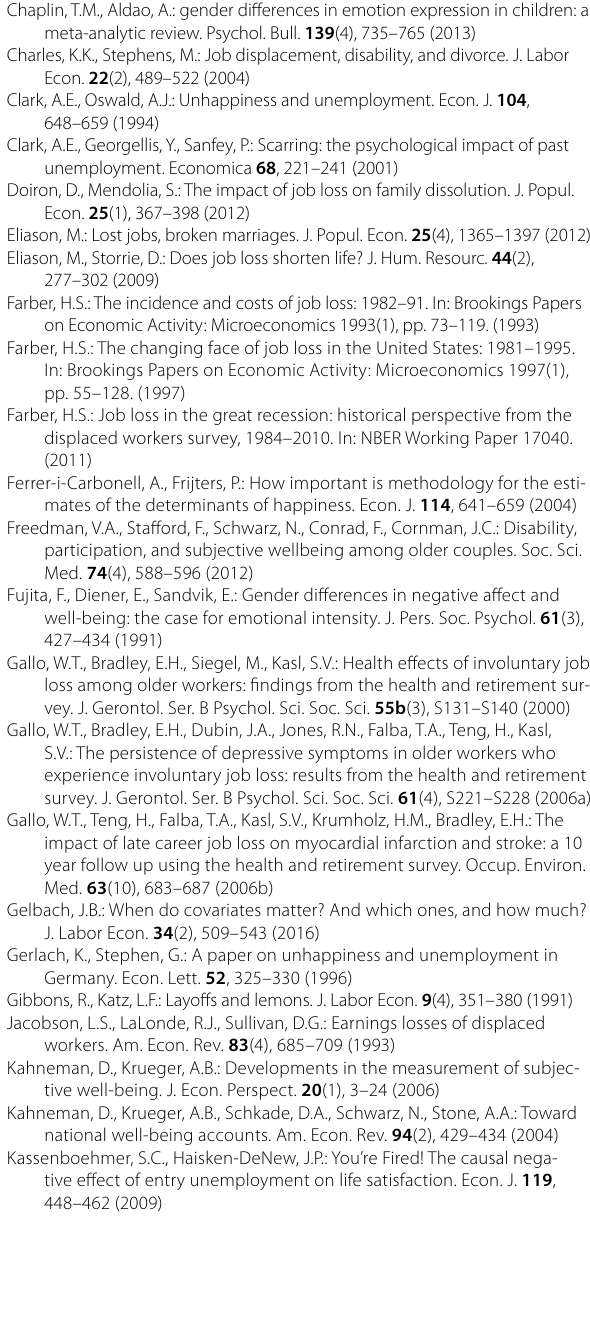
In parentheses are the unweighted percentages of displaced workers out of the total